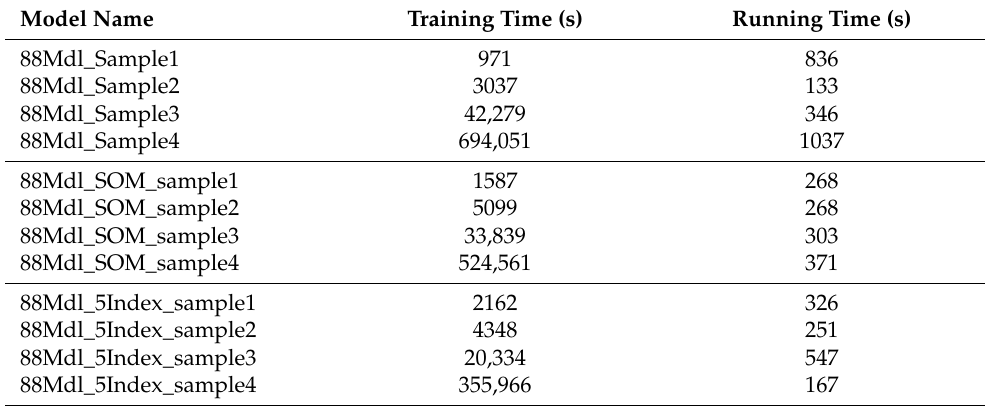
Table 8. The model training and running